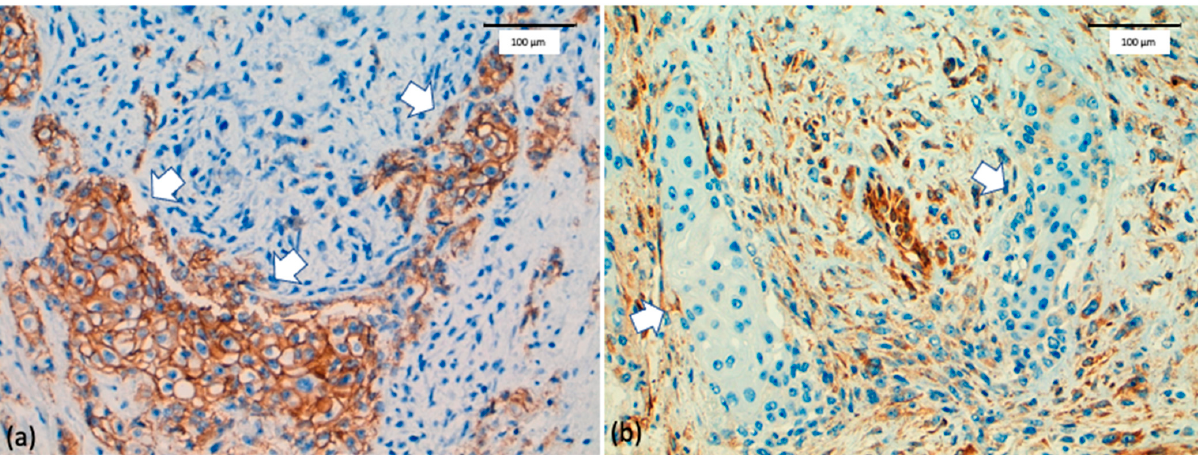
Figure 2. ( a ) E-cadherin expression is preserved in the epithelial component (arrows) and lost in the mesenchymal component of matrix-producing metaplastic breast cancer (scale bar 100 µm). ( b ) Intense SPARC expression in the mesenchymal component of matrix-producing metaplastic breast cancer. The epithelial component (arrows) is negative for SPARC (scale bar 100 µm).